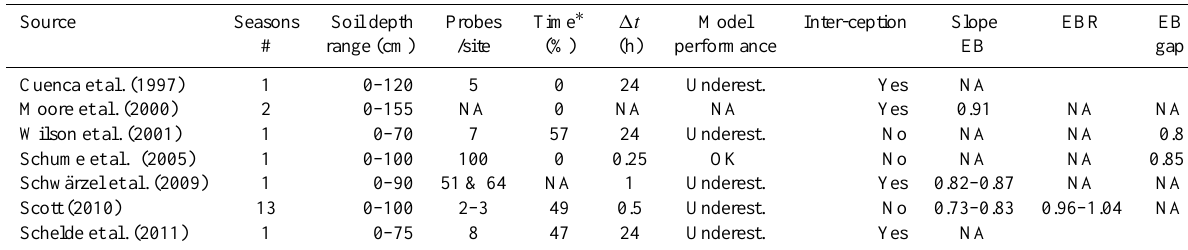
Table 1. Previous studies combining soil water balance and EC measurements.